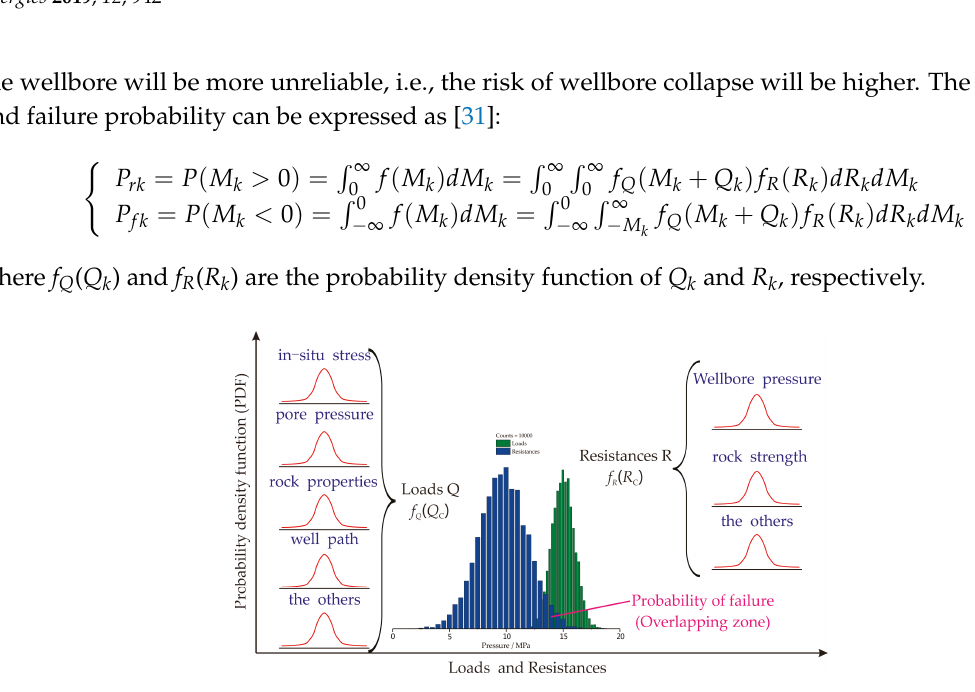
Figure 3. Both tangential and axial stresses reach the highest magnitude when (cid:908) = (cid:916) /2 or 3 (cid:916) /2, i.e.,